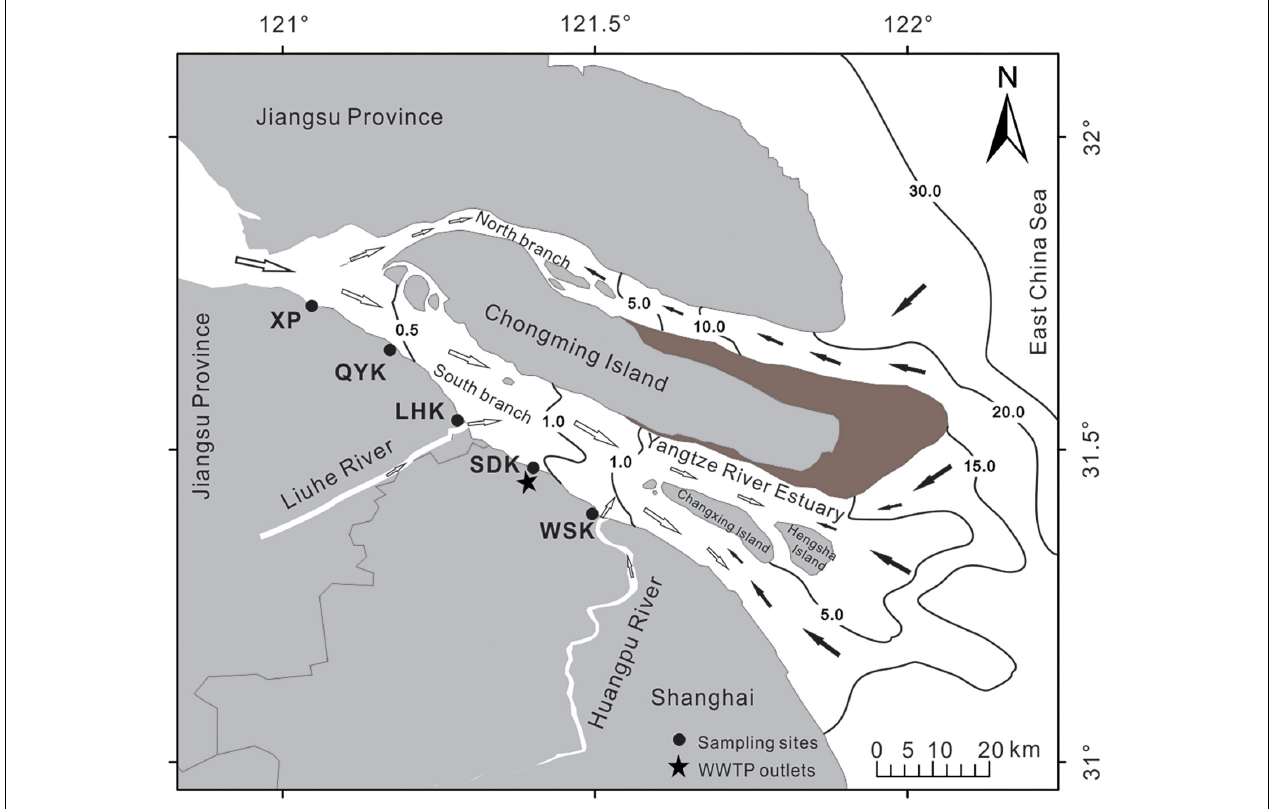
FIGURE 1 | Map of the locations of sampling sites along the Yangtze River estuary tidal mudflats. WSK = Wusongkou; SDK = Shidongkou; LHK = Liuhekou; QYK = Qiyakou; XP = Xupu. Black and white arrows indicate direction of saltwater and freshwater, respectively. Numbers on black lines represent salinity gradients. The black star indicates the outlet of Shidongkou wastewater treatment